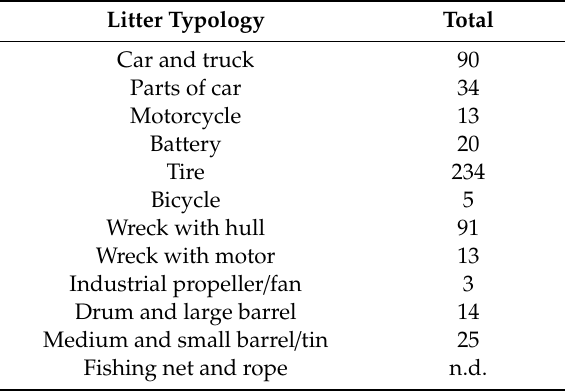
Table 2. Typology and quantity of mega-litter observed at three critical areas in the Mar Piccolo [57]. Litter Typology Total Car and truck 90 Parts of car 34 Motorcycle 13 Battery 20 Tire 234 Bicycle 5 Wreck with hull 91 Wreck with motor 13 Industrial propeller / fan 3 Drum and large barrel Medium and small barrel / tin Fishing net and rope